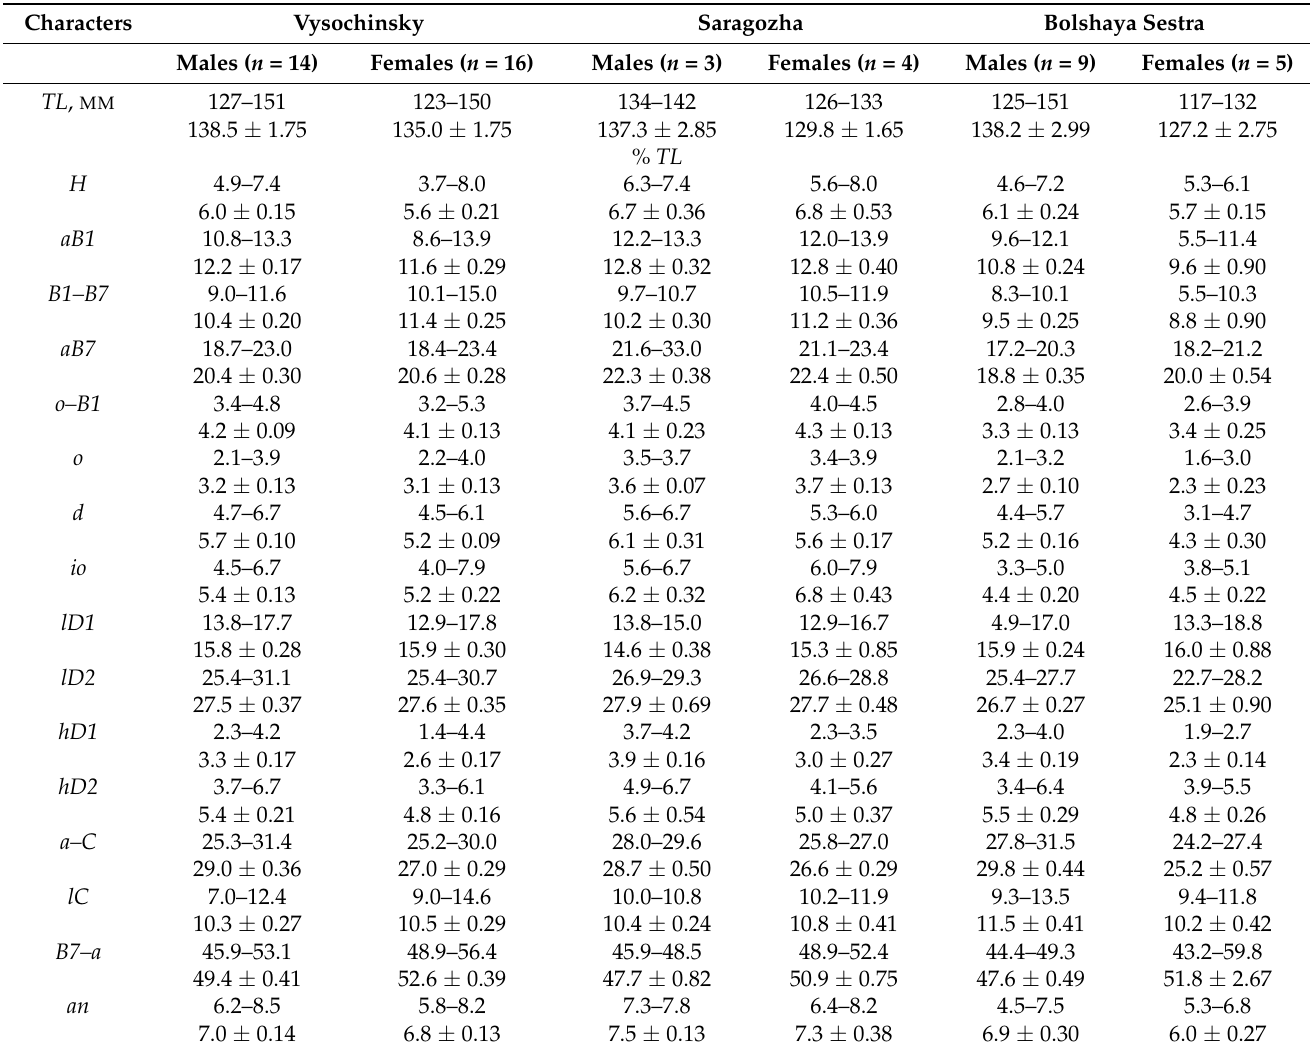
Table 2. Morphometrics in Lampetra fluviatilis mature adults. Data above the line are the ranges, and under the line is the mean ±